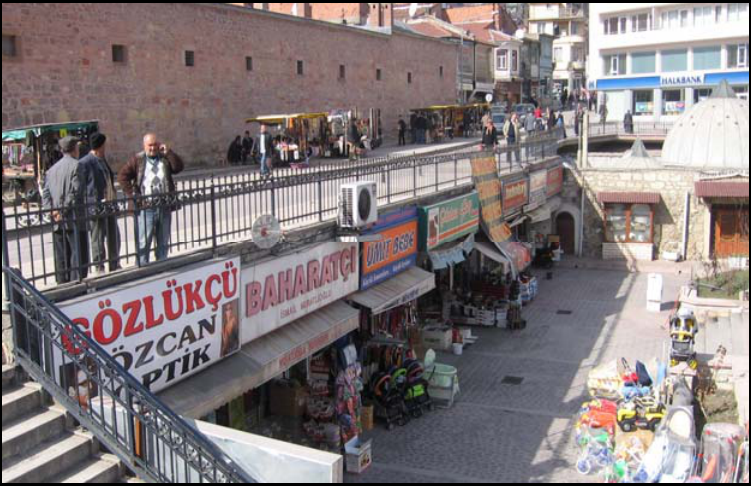
Figure 6 . Shops underneath the road in Hepbekirler